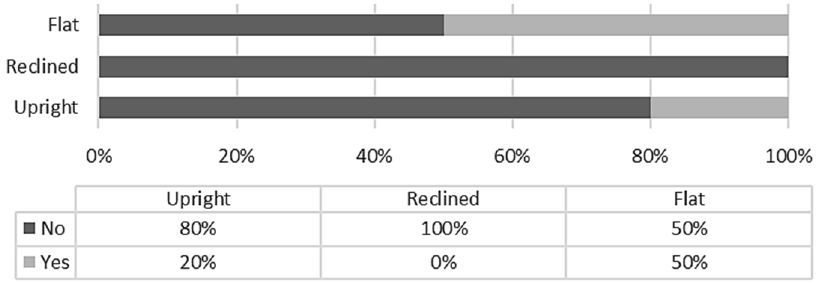
Figure 7. Seatbelt discomfort, answer to the question “Did you perceive discomfort caused by the seatbelt?”